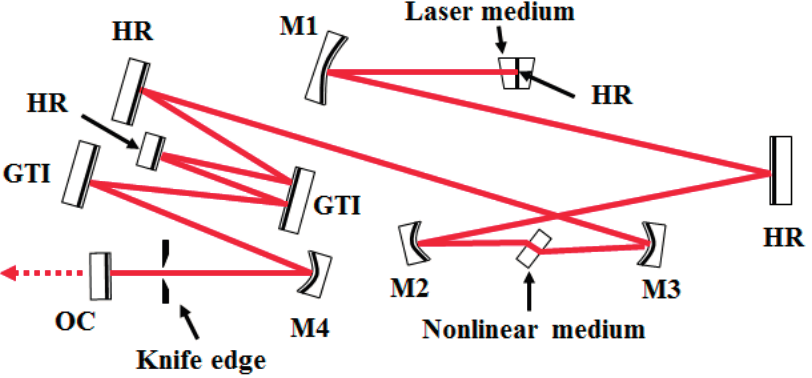
Figure 1. Schematic of the Kerr-lens mode-locked Yb:YAG laser with a highly nonlinear intra-cavity medium. HR: High reflector mirror, GTI: Gires-Tournois interferometer, OC: Output